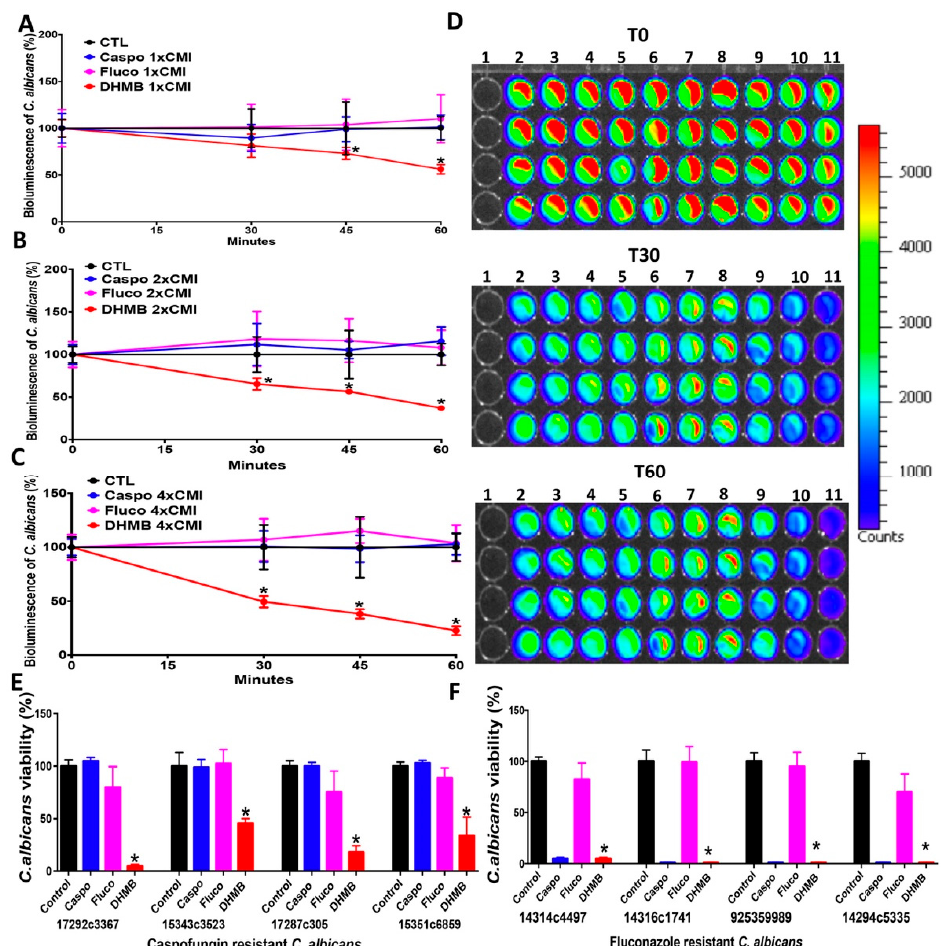
Figure 2. Impact of DHMB on C. albicans viability. ( A – C ) Bioluminescent C. albicans strain was treated with either DHMB, flucanoazole or caspofungin at their MICs, 2 × MICs or 4 × MICs and monitored at 0, 15, 30 and 60 min. Control corresponds to C. albicans alone without antifungal treatment; ( D ) Visualisation of DHMB effect on bioluminescent C. albicans strain in real time. Bioluminescent C. albicans strain was treated with either DHMB, fluconazole or caspofungin at their MICs, 2 × MICs or 4 × MICs and monitored at 0, 15, 30 and 60 min. Line 1, PBS without yeasts; Line 2, C. albicans alone; Lines 3–5, C. albicans treated with caspofungin at 1 × MIC, 2 × MIC and 4 × MIC, respectively; Lines 6–8, C. albicans challenged with fluconazole at 1 × MIC, 2 × MIC and 4 × MIC, respectively; Lines 9–11, C. albicans + DHMB at 1 x MIC, 2 × MIC and 4 × MIC, respectively. * p < 0.0001; ( E , F ) Effect of DHMB on drug-resistant C. albicans clinical isolates. Control represents C. albicans clinical isolate. Caspo (caspofungin), Fluco (fluconazole) or DHMB (2,3-dihydroxy-4-methoxybenzaldehyde) were added to C. albicans strains at 10 × MIC.